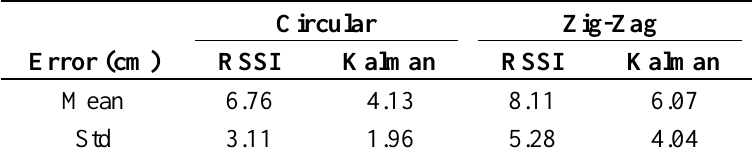
Table 1. Steady state tracking error mean and standard